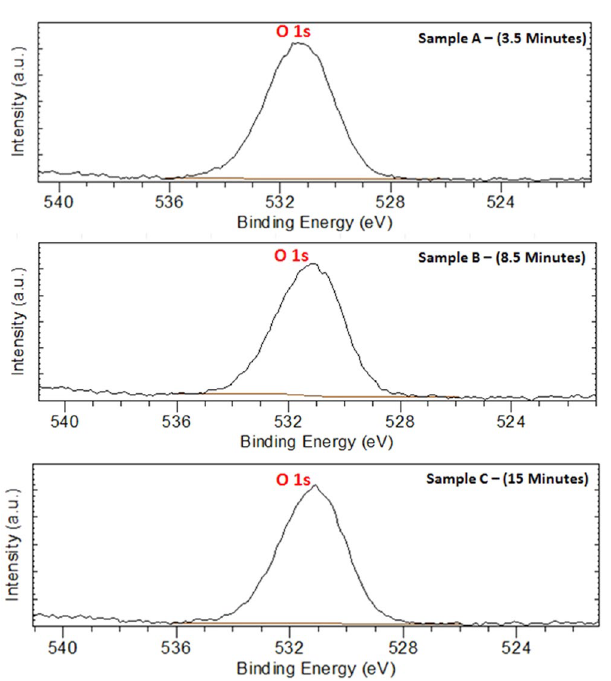
Figure 21. O 1 s XPS spectra for samples picked up at ( a ) 3.5 minutes, ( b ) 8.5 minutes, and ( c ) 15 minutes after starting of the